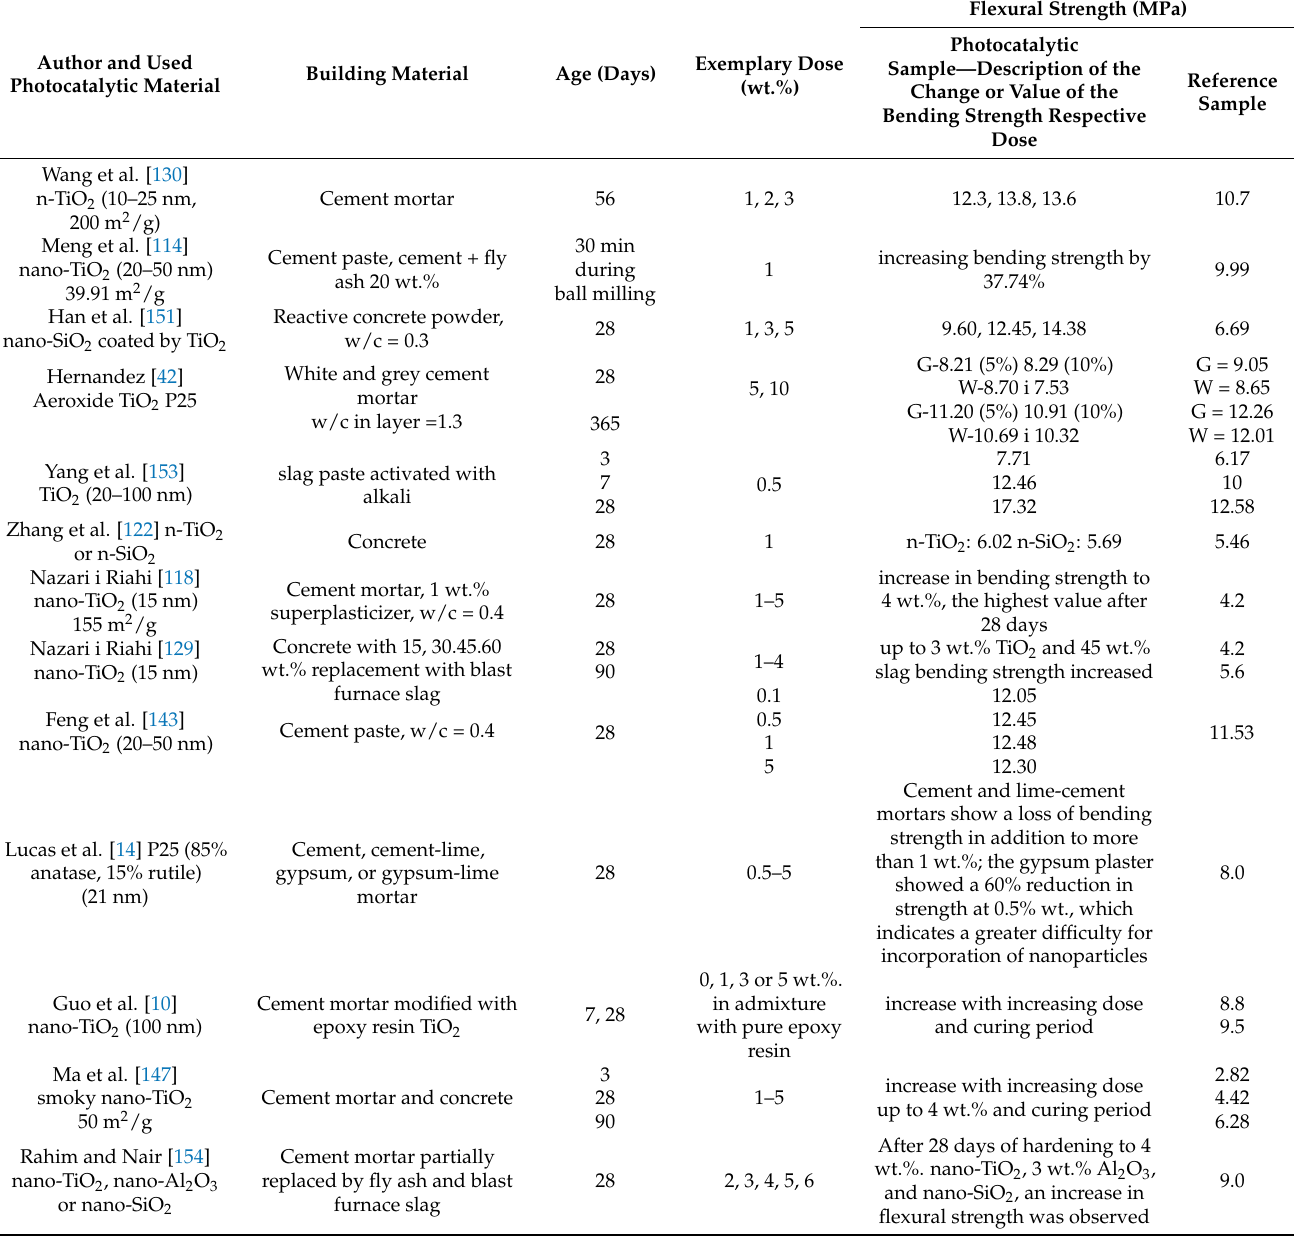
Table 3. Flexural strength of different types of building